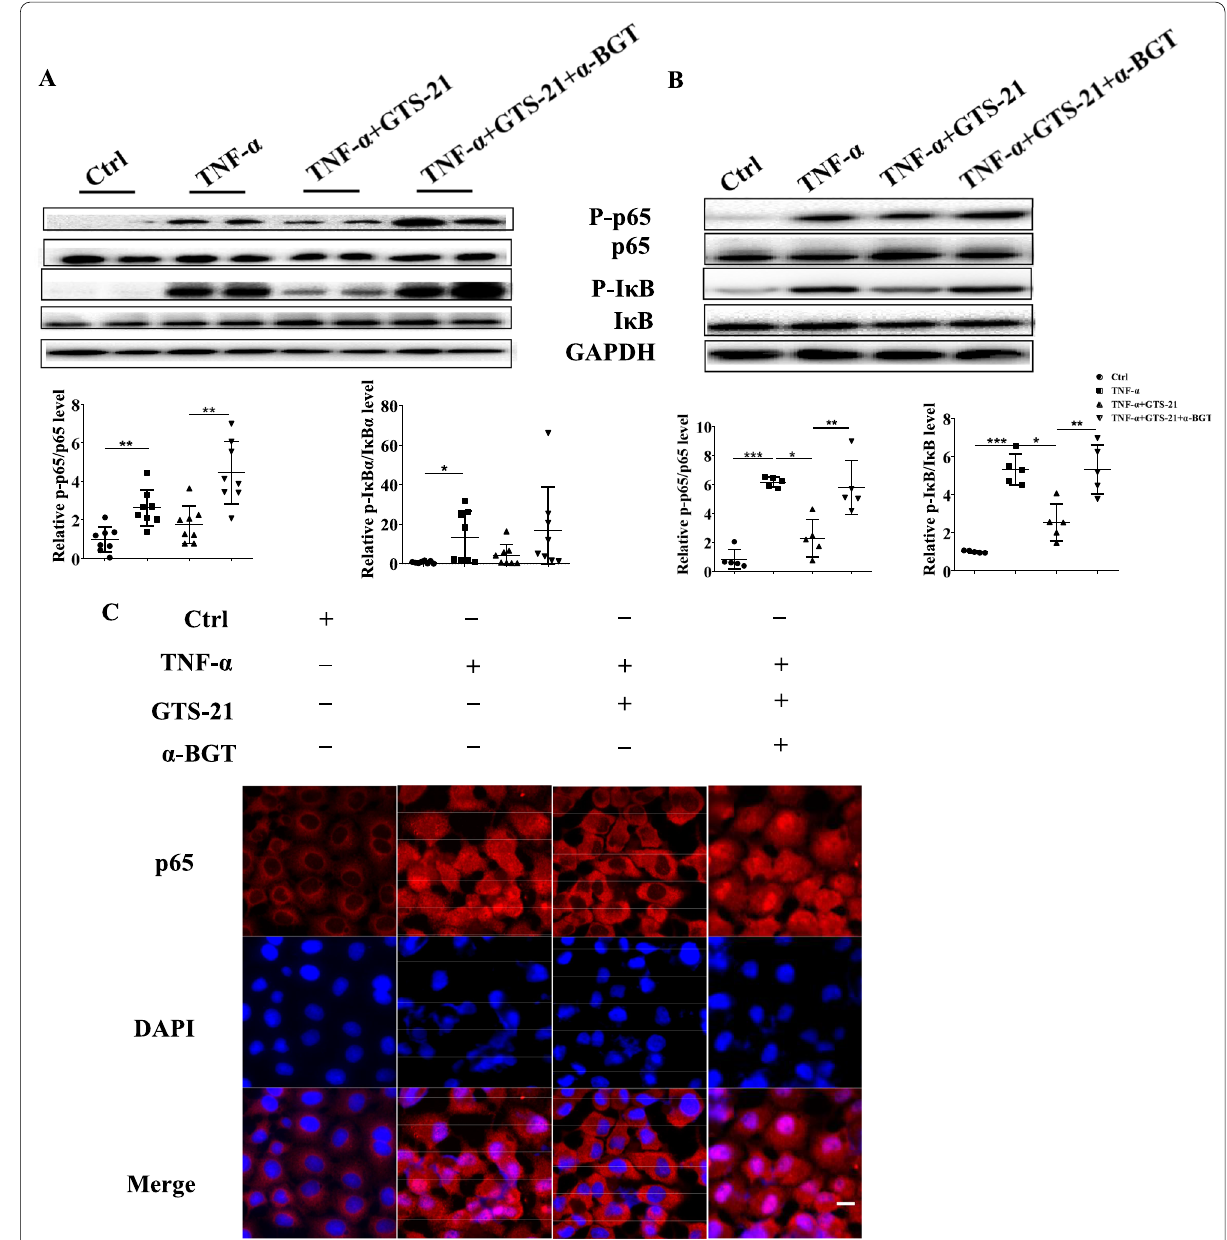
Fig. 5 GTS-21 attenuates NF- қ B activation in the intestinal tissues both in DSS-induced colitis and Caco2 monolayers. A Western blot analysis of NF-κB associated proteins (phosphorylated and non-phosphorylated IκBα, NF- қ B p65) expressions level in colonic tissues, * p < 0.05, ** p < 0.01. B Western blot analysis of NF-κB associated proteins (phosphorylated and non-phosphorylated IκBα, NF- қ B p65) expressions level in Caco2 cells incubated with TNF-α for 30 min, * p < 0.05, ** P < 0.01, *** p < 0.001. C The activation of NF-κB was detected by NF-κB nuclear translocation assays. Representative immunofluorescence of p65 (red) in Caco2 monolayers. (DAPI nuclear staining). Magnification,